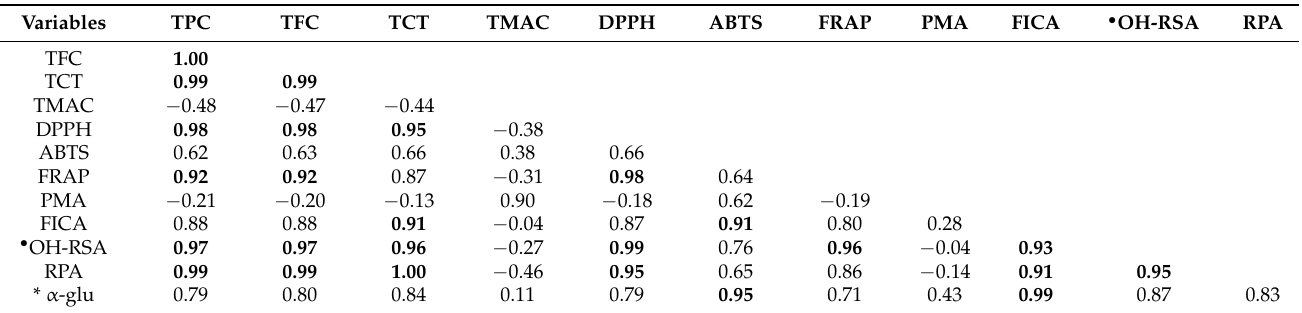
Table 2. Pearson correlation between phenolic contents and biological